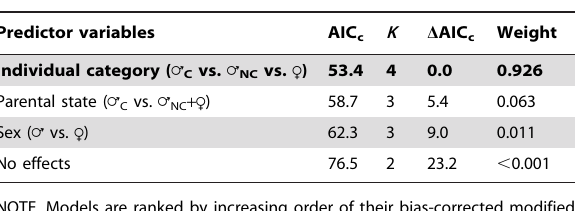
Table 2. Summary of the model selection statistics for the analysis that evaluated the monthly feeding activity of Iporangaia individuals between August 2003 and July